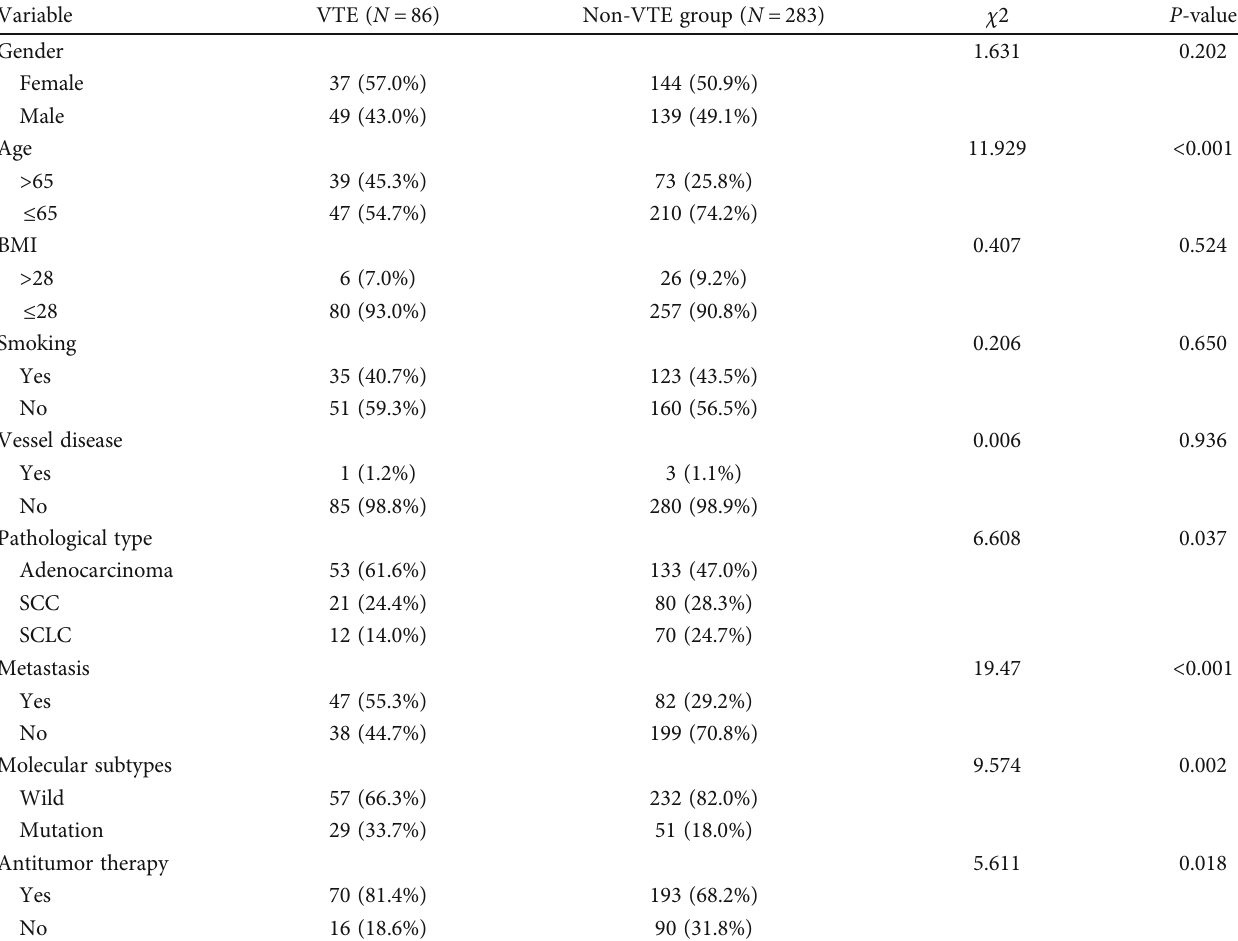
Table 1: Comparison of clinical data between VTE groups and non-VTE